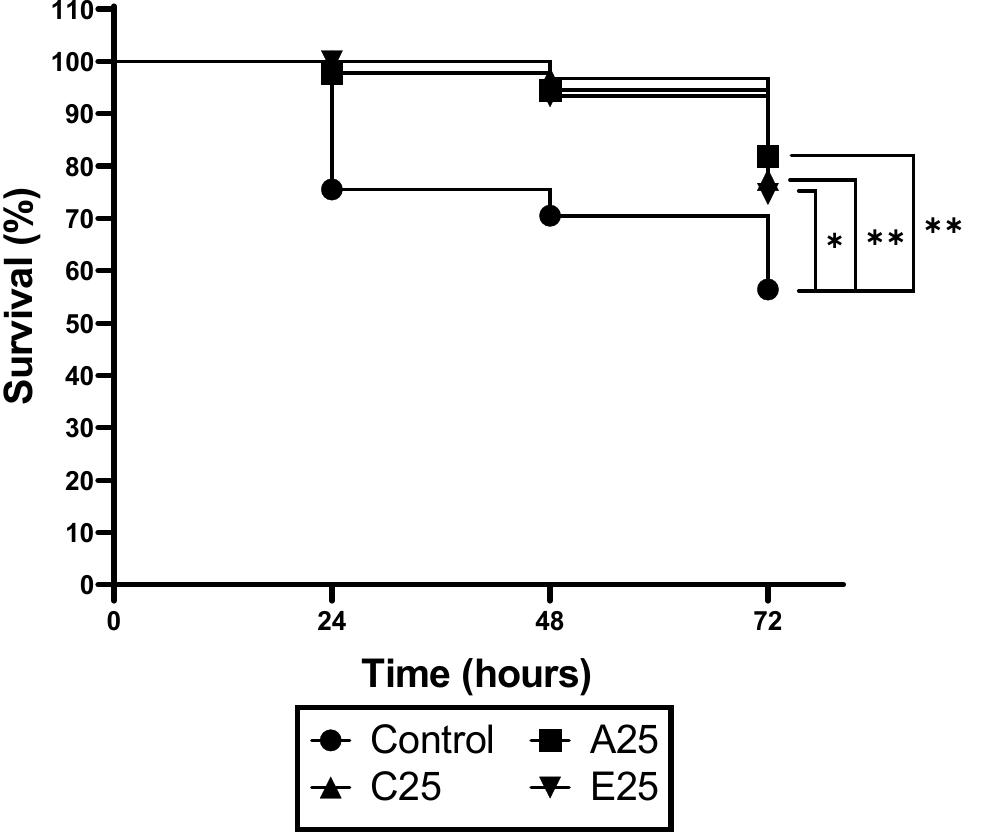
Figure 1. Response of larvae to infection by the conidia of control and passaged A. fumigatus strains. Larvae were infected with the conidia as described, and their survival was monitored over 72 h. Passaged strains showed significantly reduced virulence at 72 h (A25, * p = 0.0458; C25 and E25, ** p = 0.042. Logrank (Mantel–Cox) test).